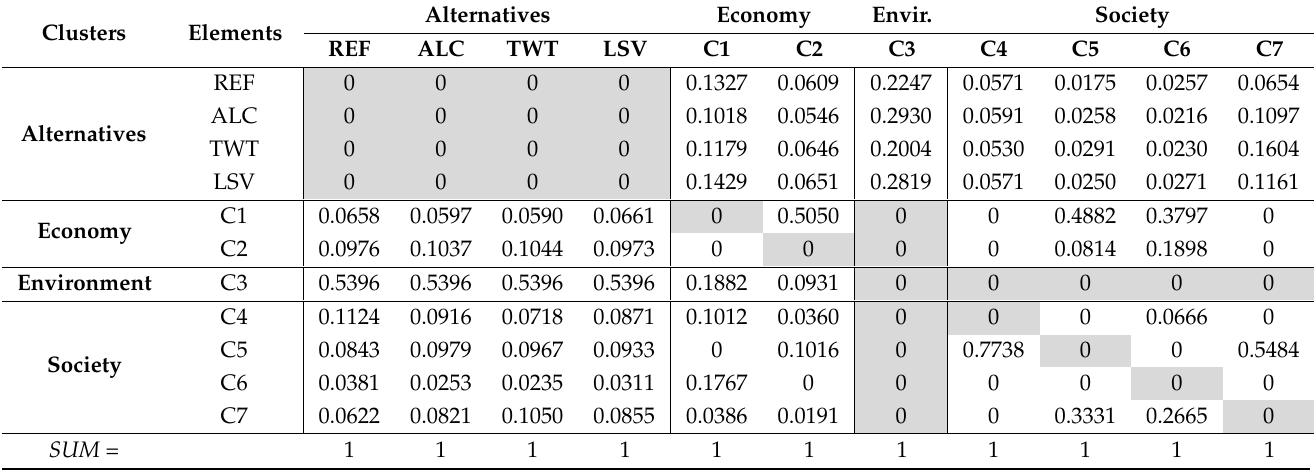
Table 8. Stochastic weighted supermatrix from DM 1.